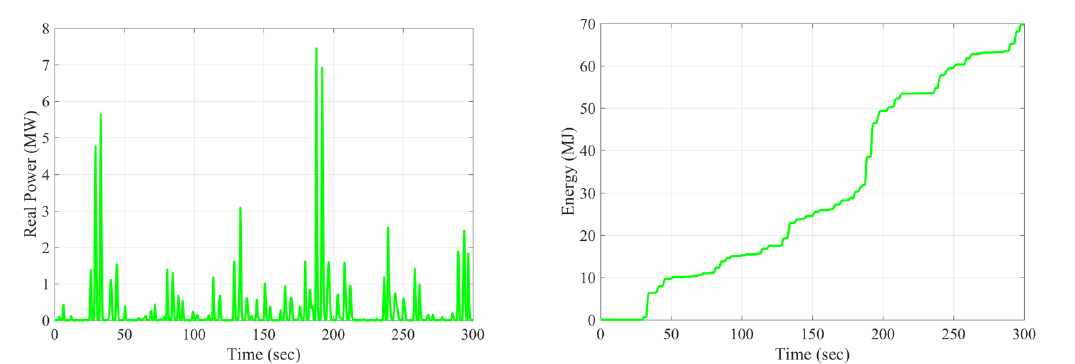
Figure 22. SS4 real power ( left ) and harvested energy ( right ), respectively.